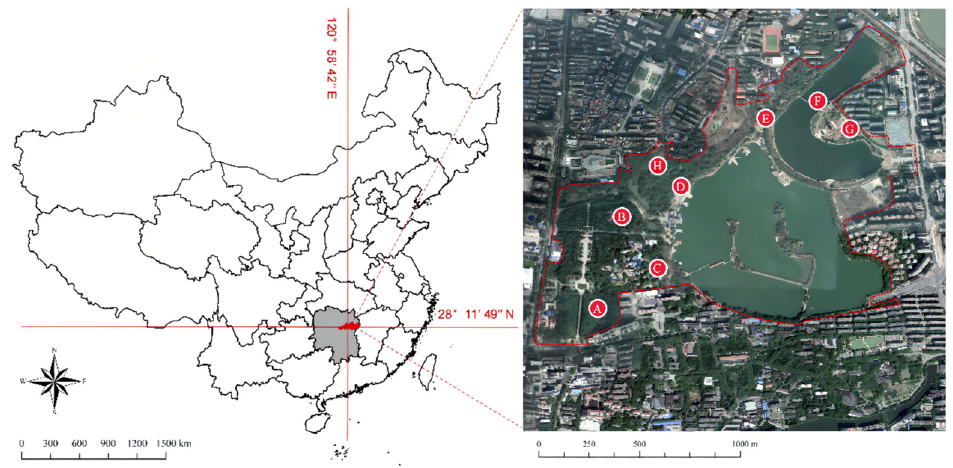
Figure 1. Park and measurement point location. Table 1. Description of the environmental characteristics of the 8 open spaces.